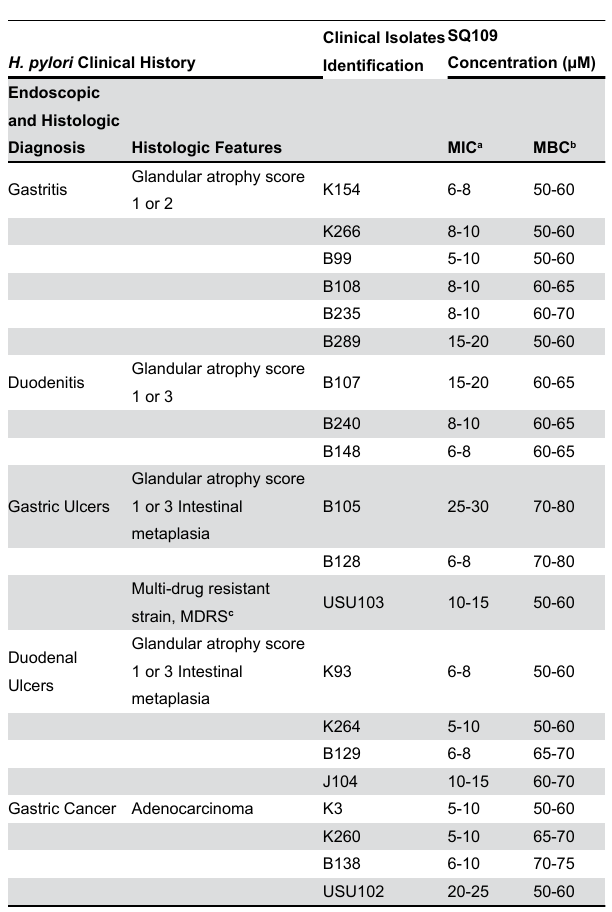
Table 2. SQ109 efficacy against H. pylori clinical